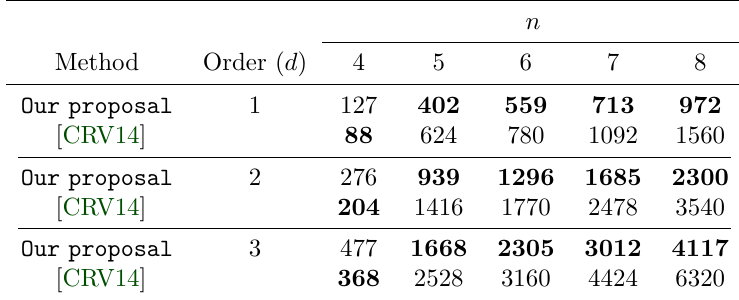
Table 6: Costs of evaluating S-boxes of size 4 ≤ n ≤ 8 with the CRV method and our alternate